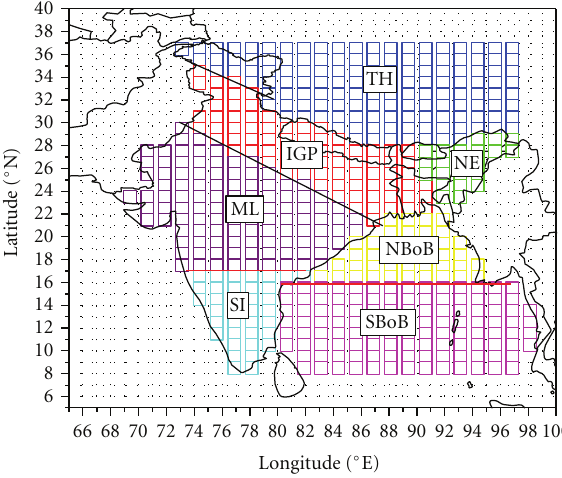
Figure 1: Indian landmass, the Tibetan glaciers, and the Bay of Bengal divided into di ff erent regions as represented by the area covered by the small square grids of same